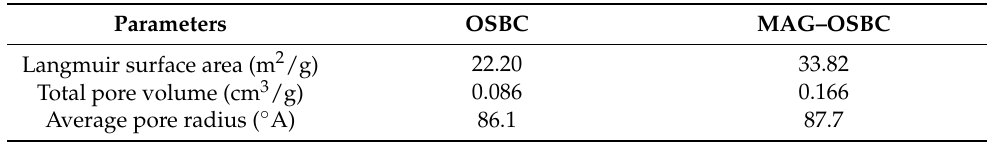
Table 4. Brunauer–Emmett–Teller (BET) analyses of thermally treated olive stones before and after loading with magnetic nanoparticles, OSBC and MAG–OSBC,